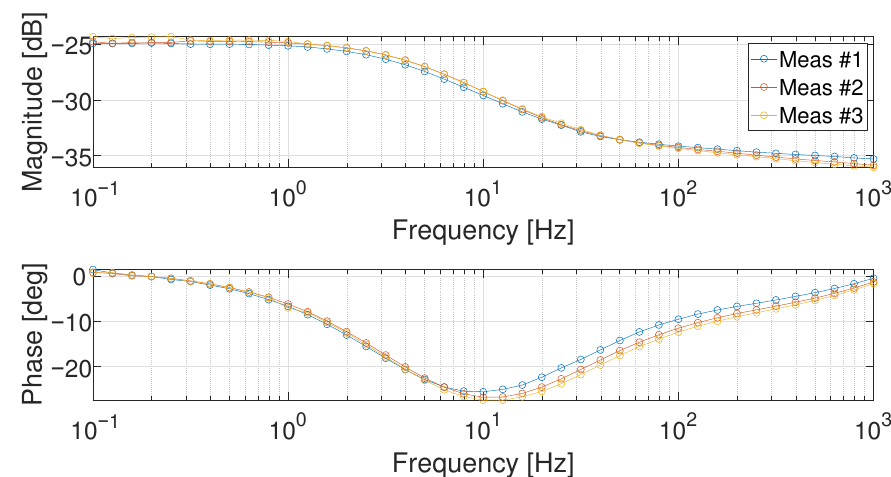
Figure 6. Bode diagrams at 1A for the three performed measurements.